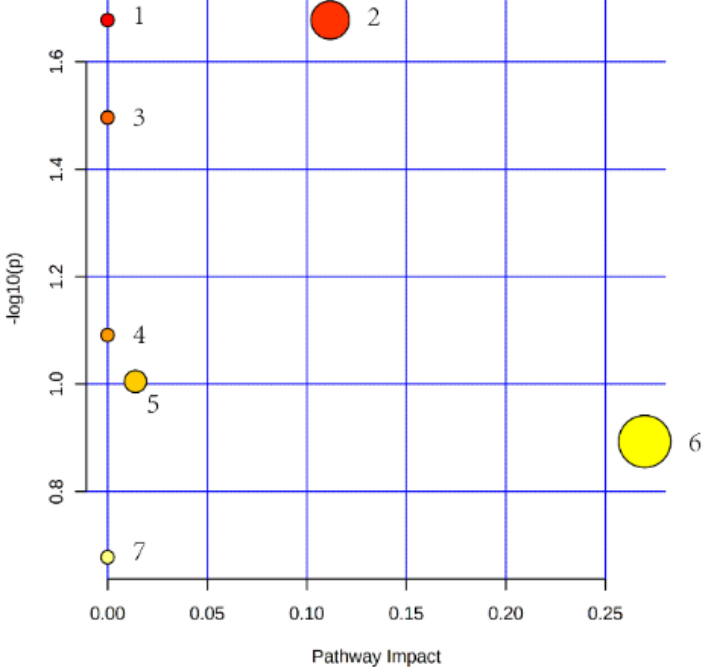
Figure 6. Lipid metabolic pathway analysis of the identified differential lipid species. (The circle size and x-axis represent the pathway impact value, and the circle color and y-axis is the -log ( p -value) obtained from pathway enrichment analysis. 1: pathway of biosynthesis of unsaturated fatty acids; 2: pathway of glycerophospholipid metabolism; 3: pathway of linoleic acid metabolism; 4: pathway of alpha-linolenic acid metabolism; 5: pathway of glycerolipid metabolism; 6: pathway of sphingolipid metabolism; 7: pathway of arachidonic acid metabolism.)